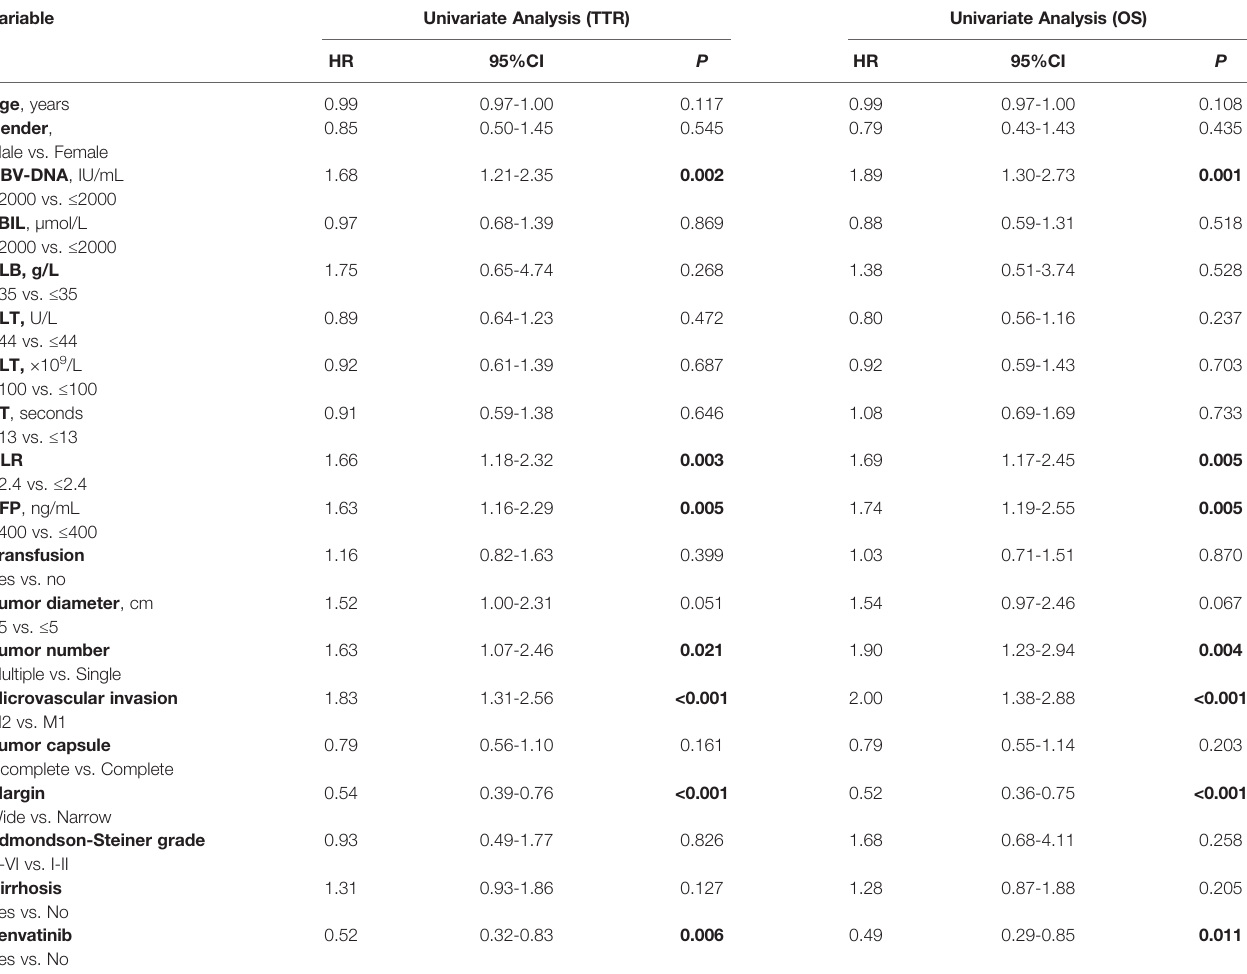
TABLE 4 | Univariate Cox-regression analysis for predicting TTR and OS in 293 HCC patients with Microvascular Invasion with and without adjuvant Lenvatinib before PSM. Variable